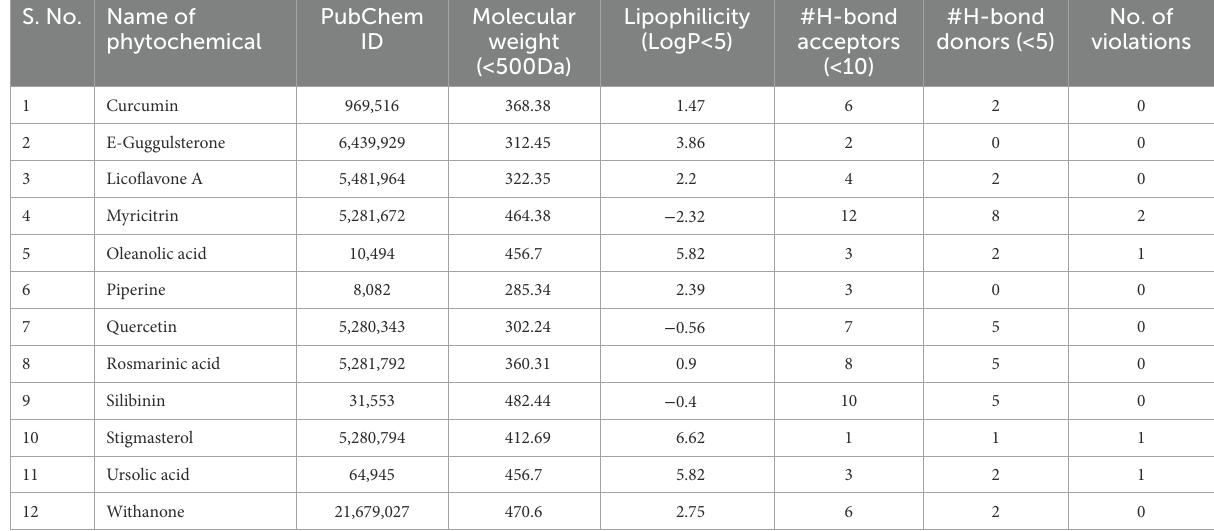
TABLE 1 Lipinski rule of five values for the test